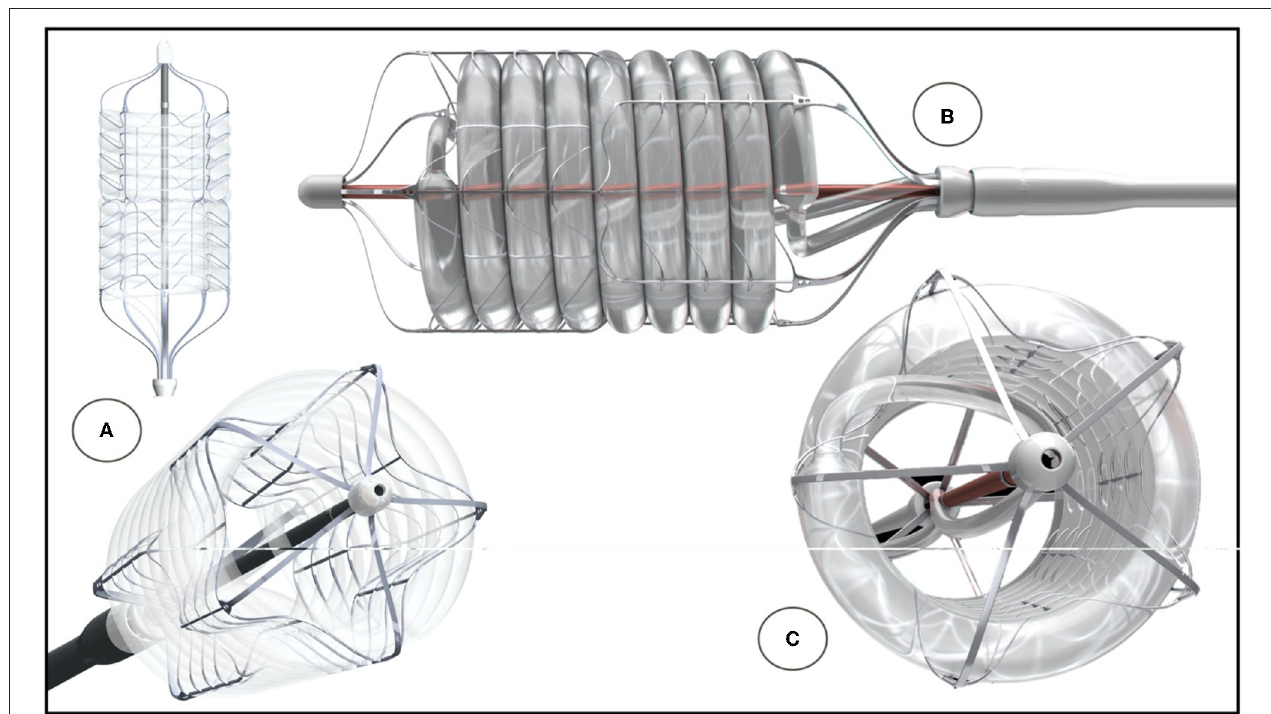
FIGURE 12 | SAT helical dilatation balloon. The helix is prevented from toppling by a fine-meshed Nitinol frame (C) . A directional change at mid-level allows mirror-imaging of the proximal and distal ends (A) . Profile of combined helical balloon and support frame (B) . Dual inflation from both sides and relatively large feeding lines allow rapid inflation (C)